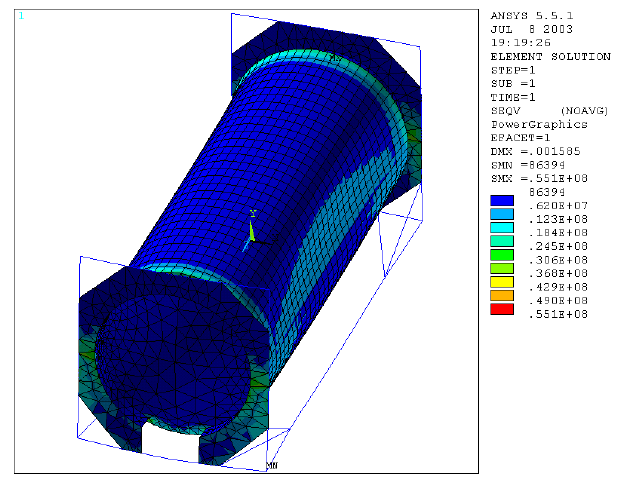
Figure 13. Equivalent stress.